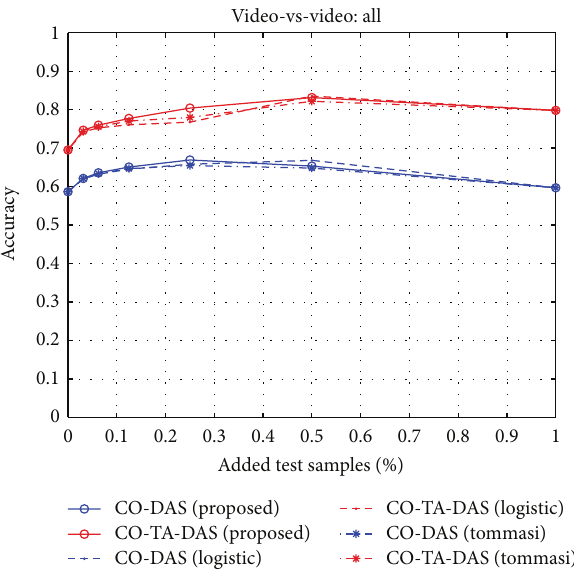
Figure 13: Comparison of the performances of the types of confidence measures for the Co-Training feedback loop. Plot of the average accuracy as a function of the amount of Co-Training feedback (video-versus-video setup, ALL